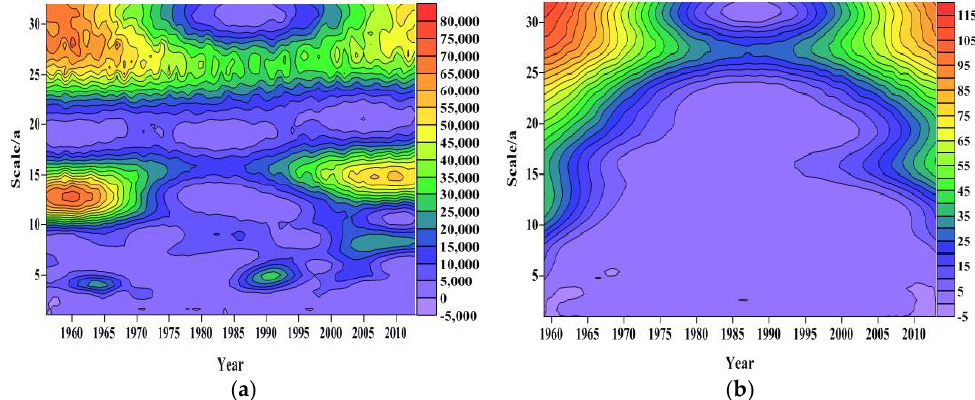
Figure 6. Contour map of the wavelet coefficients modulus square. ( a ) for atmospheric precipitation; ( b ) for spring water level.